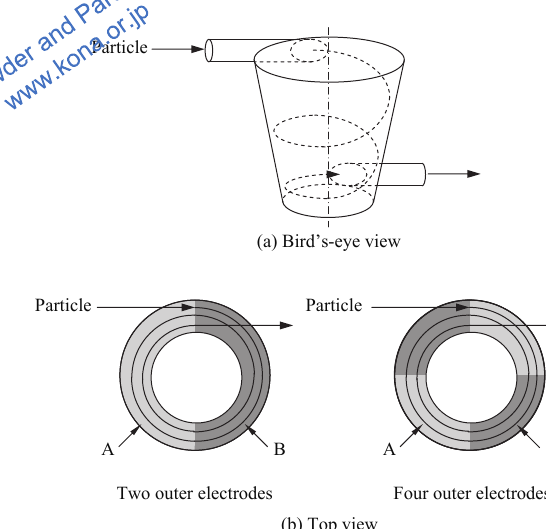
Fig. 5 Particle charger using centrifugal contact.